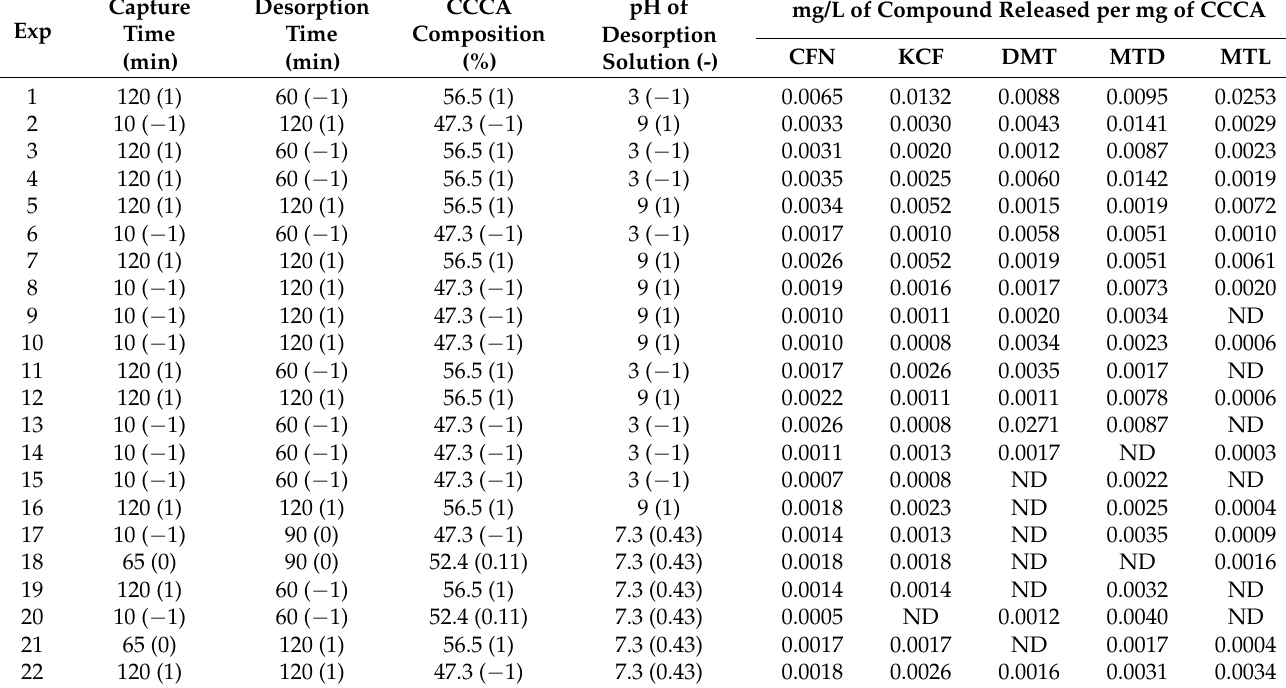
Table 4. Assay to describe and optimize the capture and desorption of selected compounds by CCCA microparticles with mechanical agitation. Numbers in parentheses correspond to the coded values of the variables under study (ND: Not